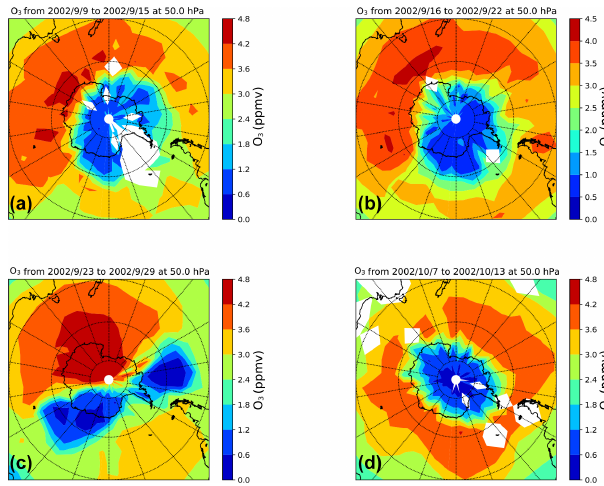
Figure 12. Distribution of the weekly means of ozone VMR at 50hPa over the Southern polar region during the 2002 vortex split- up: (a) 9–15 September, (b) 16–22 September, (c) 23–29 Septem- ber, and (d) 7–13 October 2002.